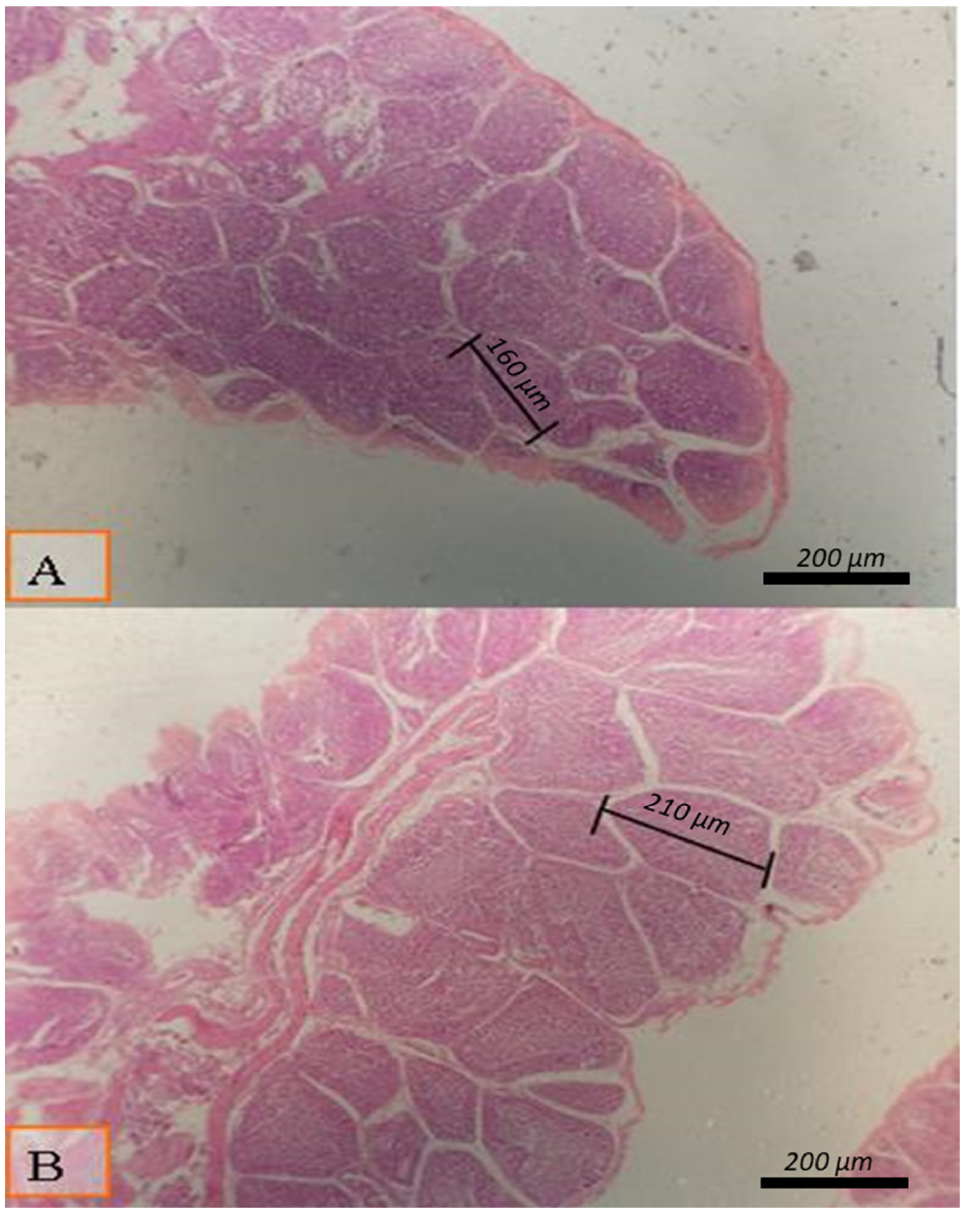
Figure 1. Micrograph of bursa of Fabricious of broiler at day 38 of age stained with HandE (X40) to investigate the follicle diameter in different groups; the distance between two follicular polar as presented all groups by lines: ( A ) Broilers supplemented with 0.02% Saccharomyces cerevisiae ;( B ) broilers supplemented with 0.04% Saccharomyces cerevisiae . Moderate enhancement in the follicular diameter was detected in broilers supplemented with 0.04% Saccharomyces cerevisiae ( B ).